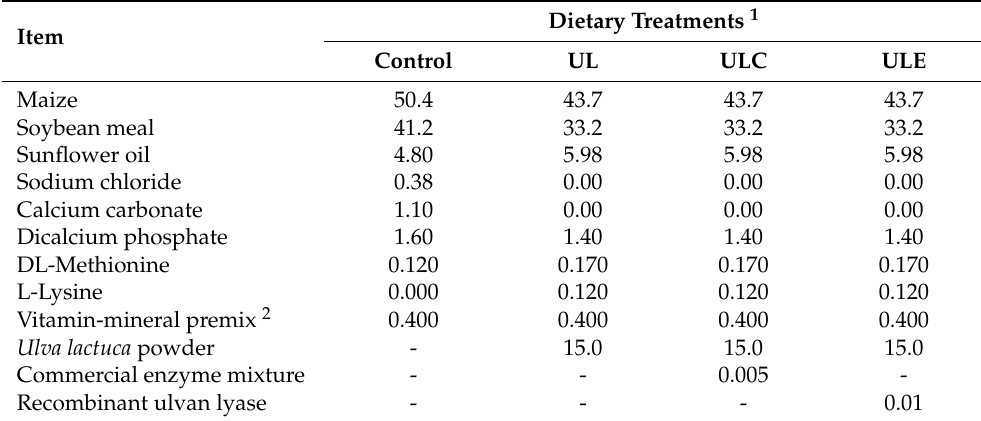
Table 1. Ingredients and feed supplements of dietary treatments (% as fed